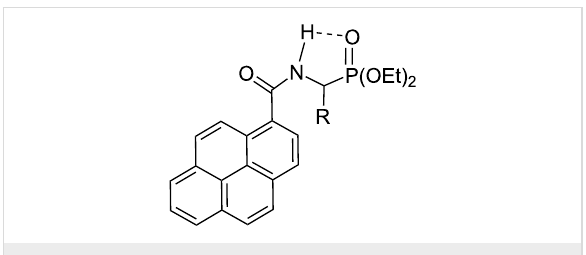
Figure 4: Intramolecular hydrogen bond in 3a–d .